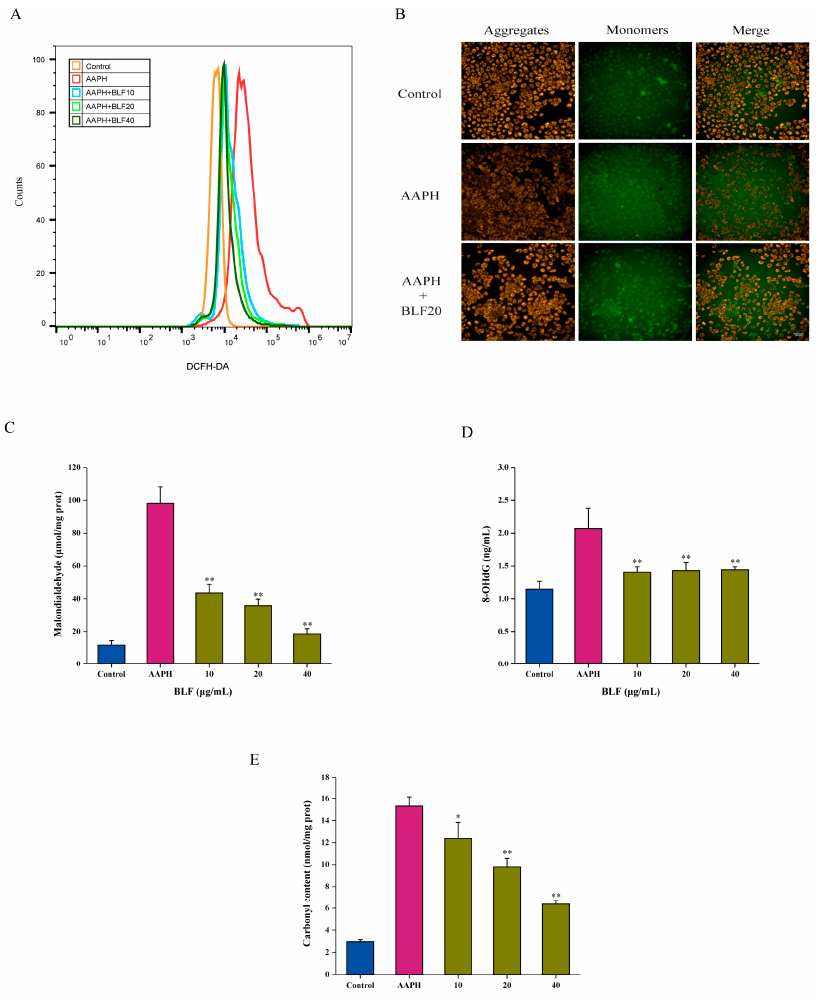
Figure 2. BLF inhibited AAPH-induced oxidative stress. ( A ) ROS level measured by DCFH-DA stain- ing and detected by flow cytometry. ( B ) Representative images of mitochondrial membrane potential. Scale bar = 100 µ m. ( C ) Malondialdehyde detected using lipid oxidation (MDA) assay kit. ( D )